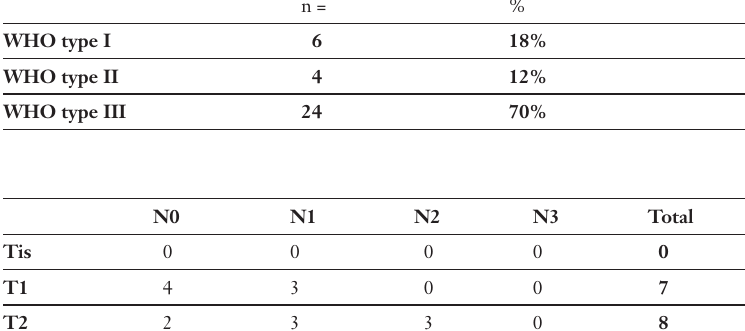
Distribution of histopathological types according to WHO classification.